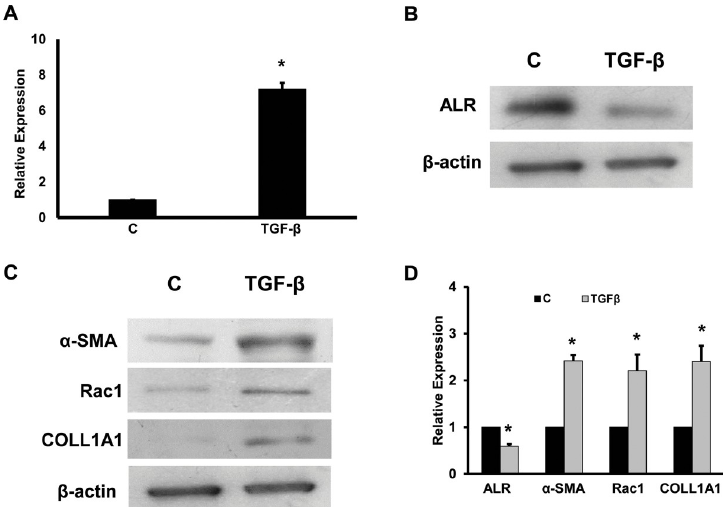
Fig 2. Effect of TGF- β on miRNA-181a, ALR and fibrogenic markers. LX2 cells were incubated with TGF- β for 24 hours under serum-free conditions. A. Total RNA was purified and real-time RTPCR was performed for miRNA-181a expression (n = 3; � p < 0.05, compared to control). Lane 1, control cells; Lane 2, TGF- β treated cells. B. The total cellular protein was isolated and Western blots were run for ALR protein. β -actin was used as an internal control. C. Western blots were performed for α -SMA, rac1, COLL1A1 and β -actin. A representative gel picture is shown (n = 3). Lane 1, control cells; and Lane 2, TGF- β treated cells. D. The Western blots from 3 experiments were quantitated using Image J software and presented as relative expression ( � p < 0.05, compared to control).